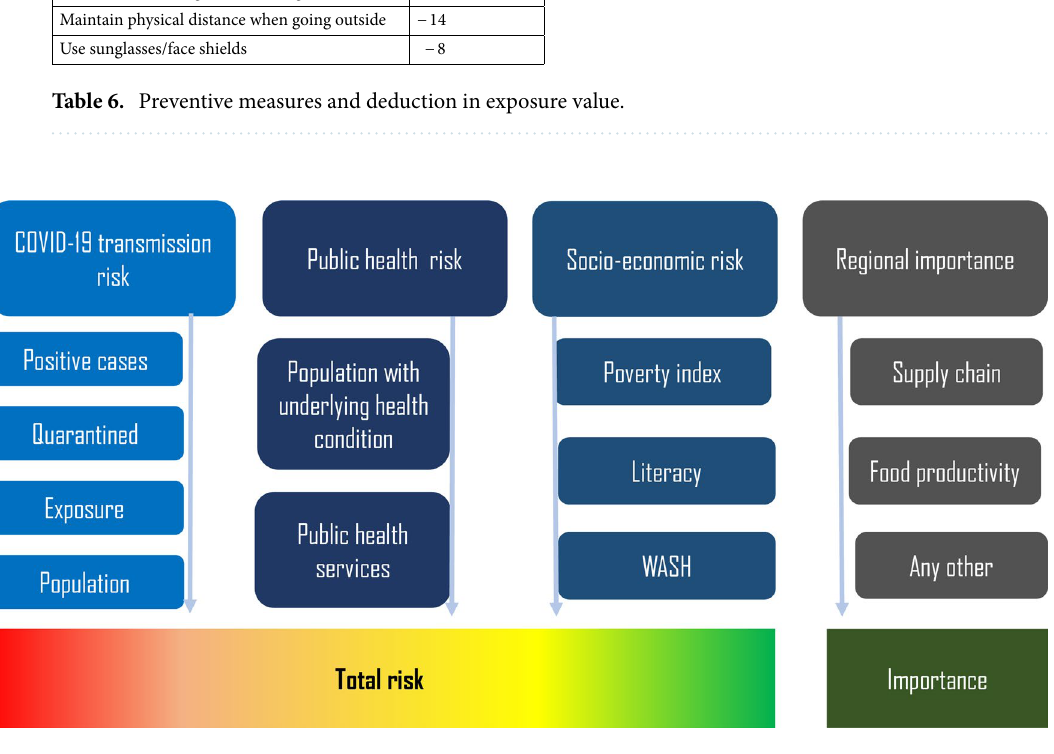
Figure 8. Framework and components for total COVID-19 risk